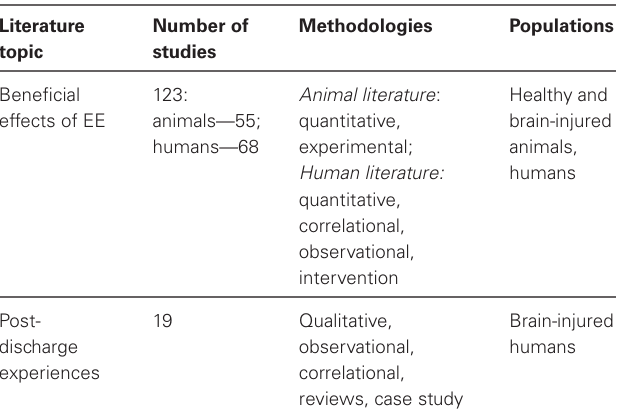
Table 1 | Numerical summary of articles